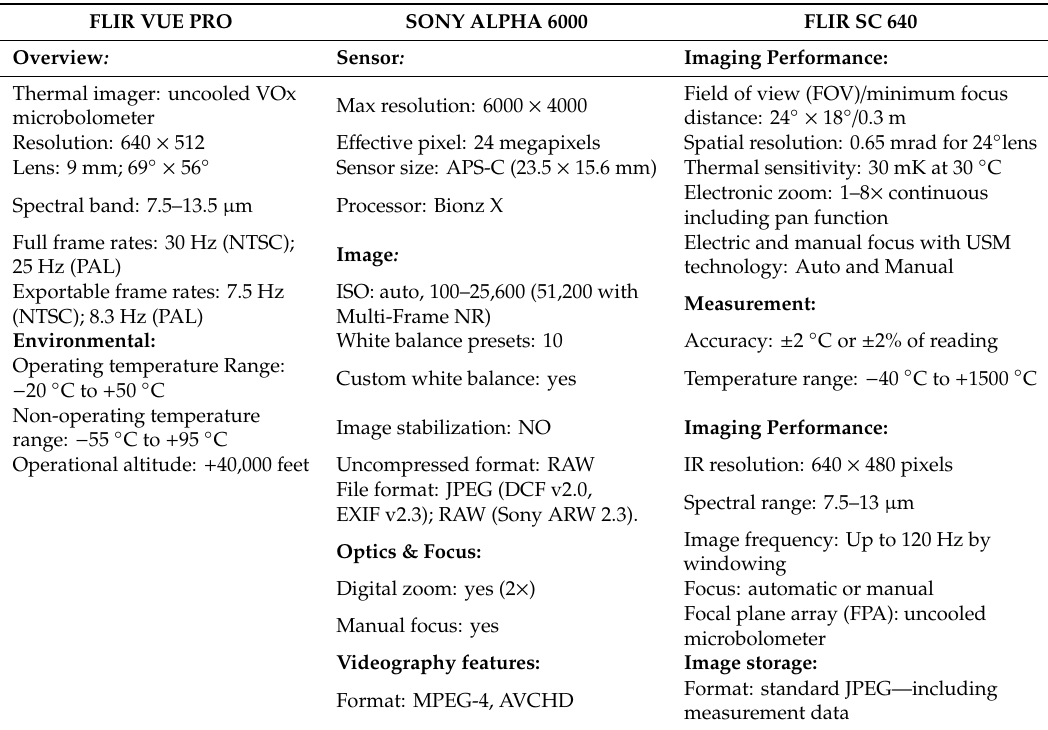
Table 2. Main technical specifications of sensors: FLIR VUE PRO (unmanned aerial vehicle (UAV) thermal cam); SONY ALFPHA 6000 (UAV visible-cam); FLIR SC 640 (hand-held thermal camera). FLIR VUE PRO SONY ALPHA 6000 FLIR SC